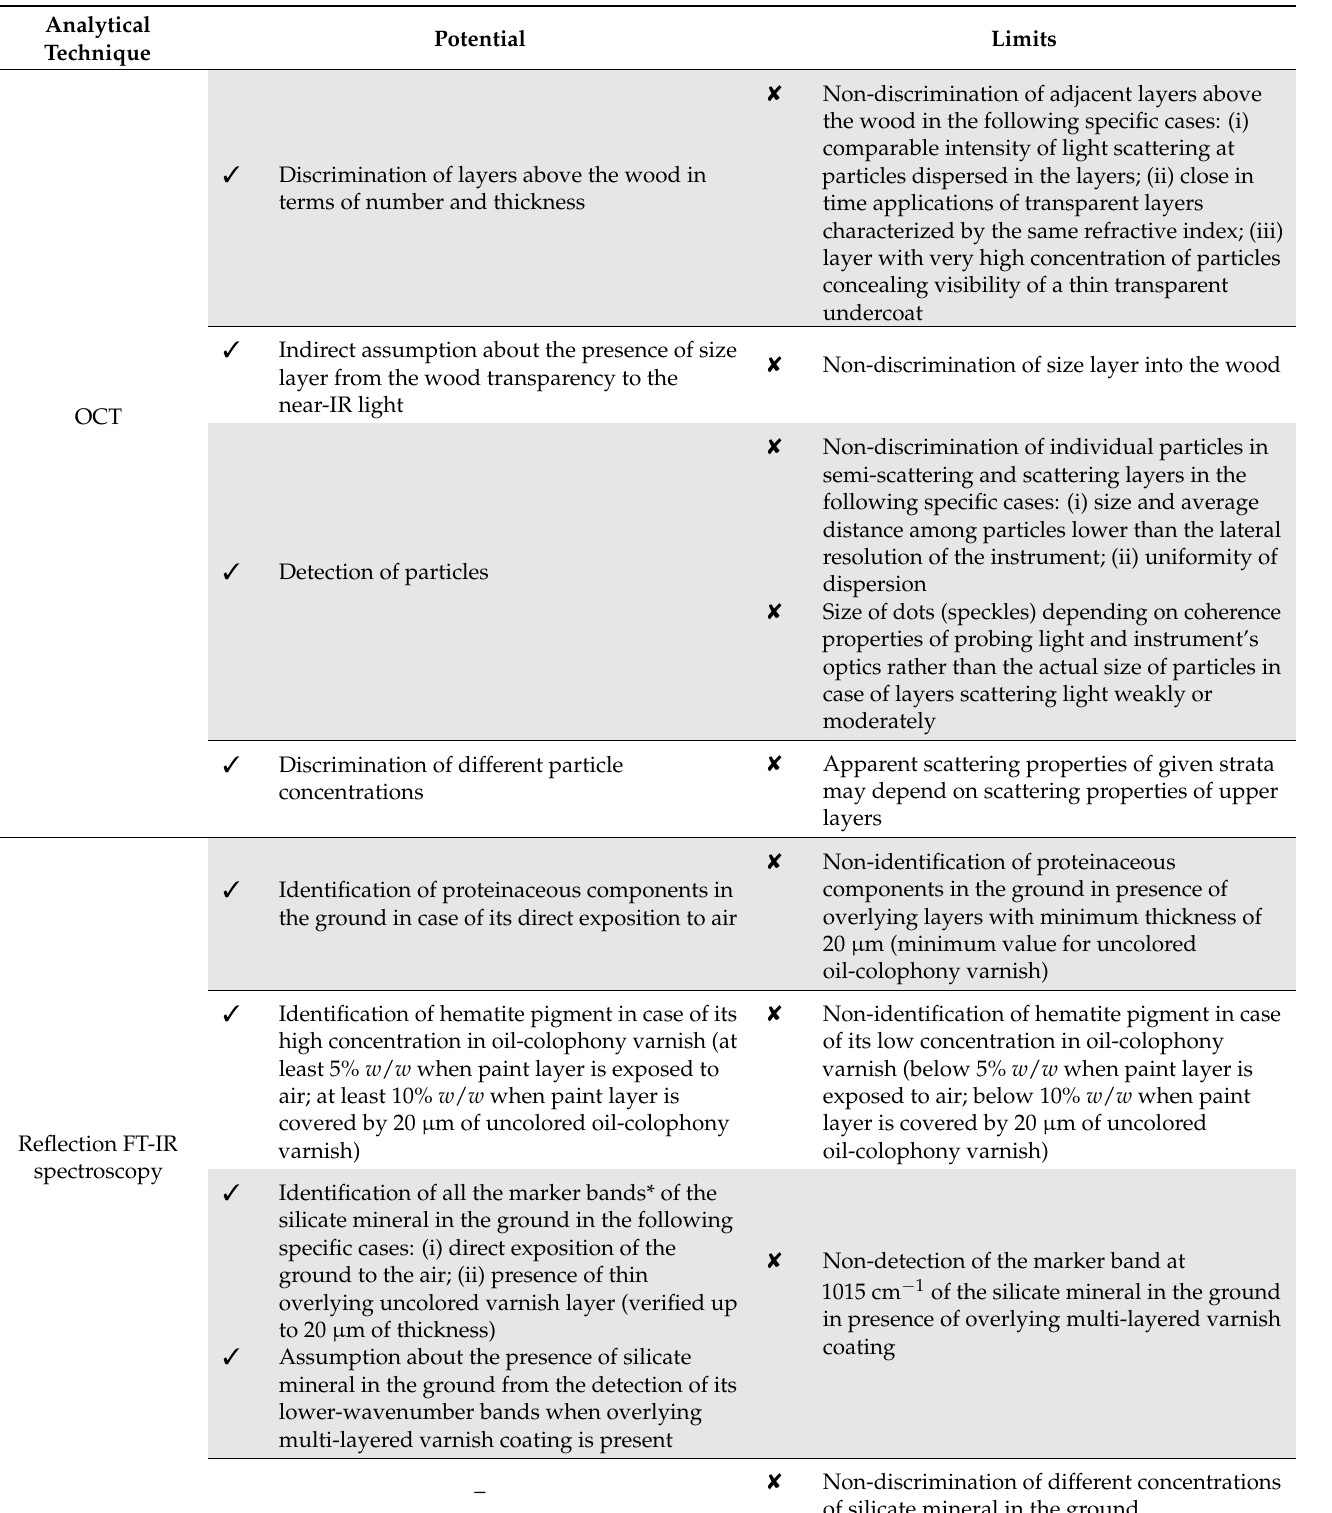
Table 2. Summary of the potential and limits of different non-invasive techniques applied to the study of the dried mock-ups ( t 0 ) investigated in this